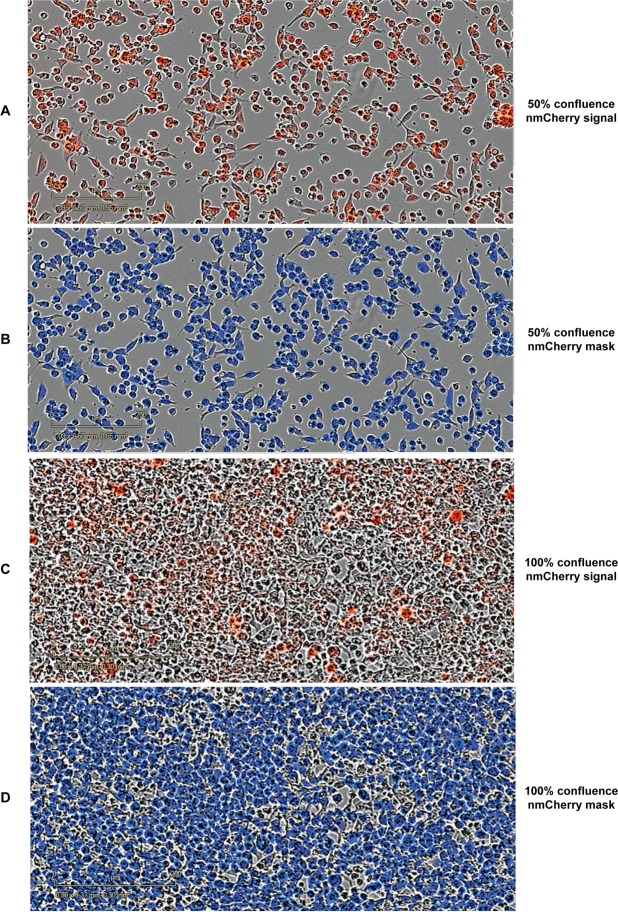
Example of images acquired on and analyzed by the Incucyte ZOOM to obtain data about the number of nuclei and their average area.(A) HEK293 cells labelled with nmCherry growing at ~50% confluence. (B) The same field of view in A displaying the nmCherry mask used for estimating nuclear area and count as estimated by the Incucyte image analysis software. (C) Same as (A) at ~100% confluence. (D) Same as (B) at 100% confluence.